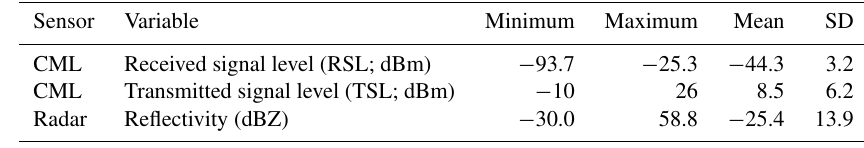
Table 5. Descriptive statistics of the collected CML and radar data. SD refers to standard deviation.